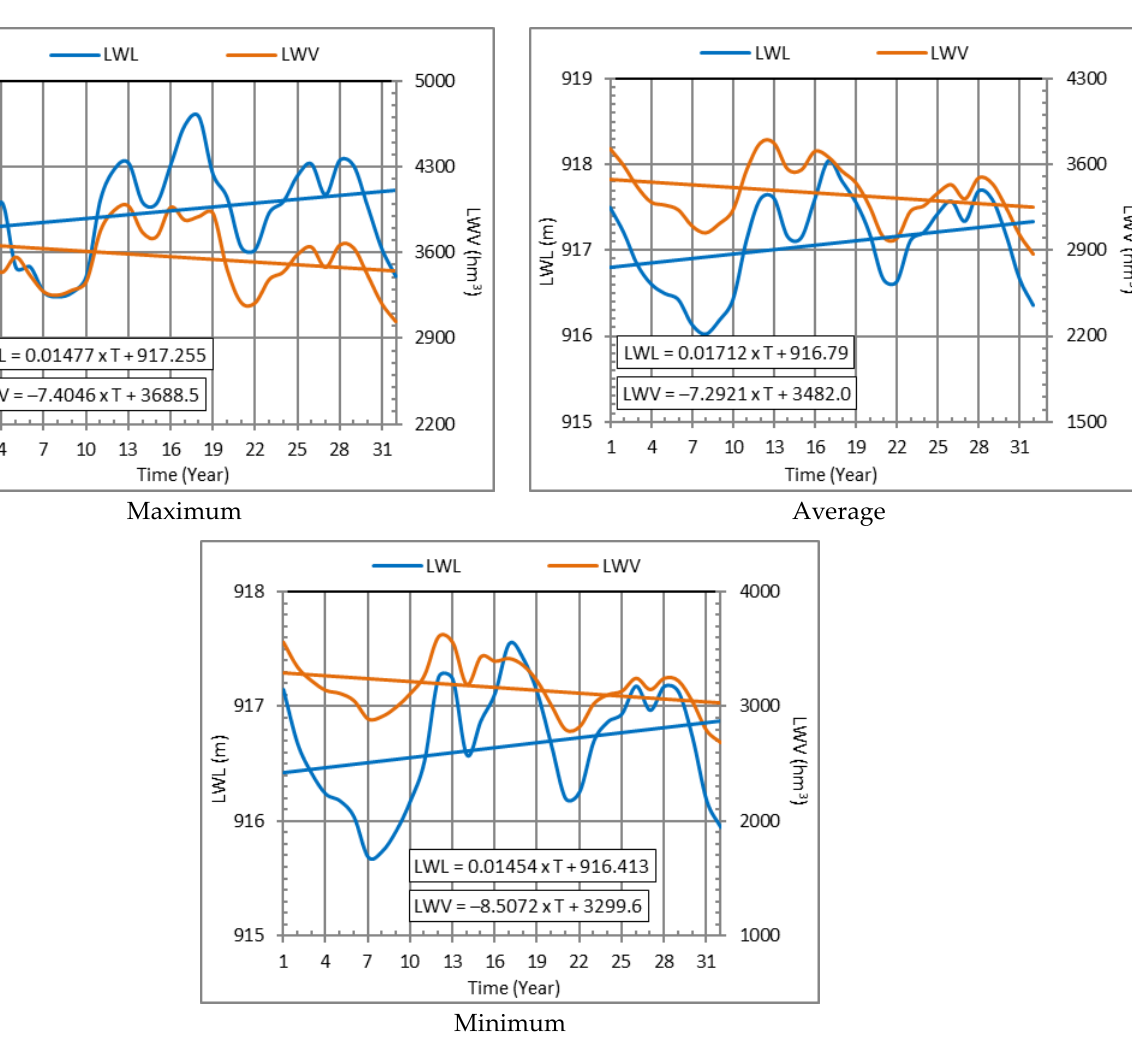
Figure 3. Measured annual LWL and LWV series of Lake Eğirdir.